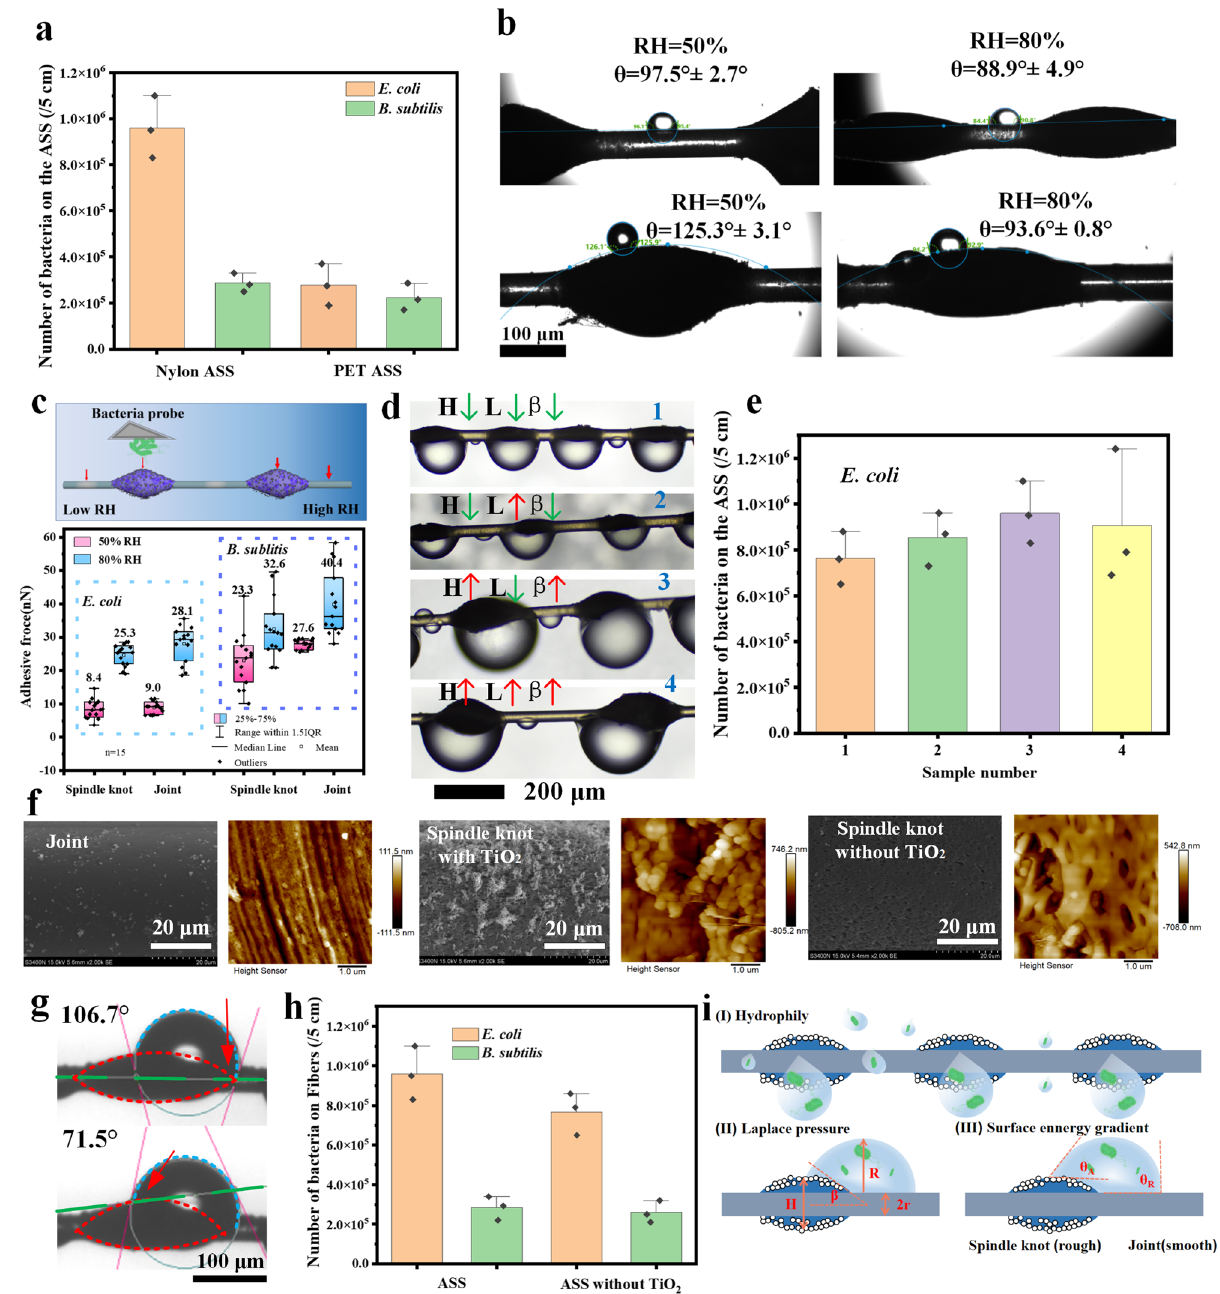
Fig.3|BioaerosolscapturemechanismsoftheASSphotocatalyst.a Bioaerosols capture performance of the ASS photocatalyst with different fi ber substrate (The errorbarsarecalculatedviarepeatingthemeasurementsforthreetimes( n =3)and data are presented as mean values±SD). b Water contact angles of the single ASS photocatalyst atdifferent RH (The independent experiment hasbeen repeated for three times, and similar results were obtained). c Adhesive force between the bacteria and the ASS photocatalyst at different RH (The independent experiment has been repeated 15 times, and similar results were obtained, n =15). d Optical images of captured bioaerosols by the ASS photocatalyst with different β , height (H) of the spindle knots, and length (L) of the joints. e Bioaerosols capture per- formance of the ASS photocatalyst with different morphology (The error bars